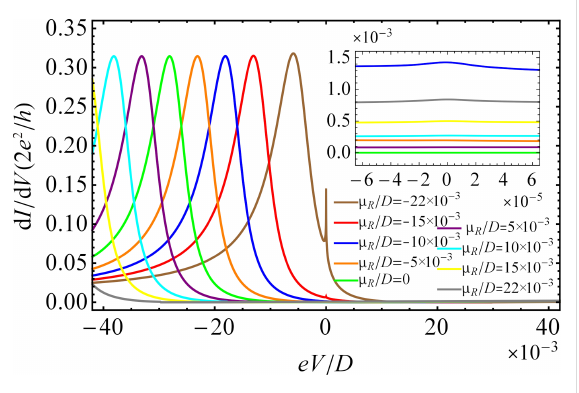
Figure 6: Differential conductance d I /d V as a function of the bias voltage eV for different values of the chemical potential μ R at tempera- ture T / D = 5 × 10 − 6 in the absence of a magnetic field. The remaining parameters are the same as those in Figure